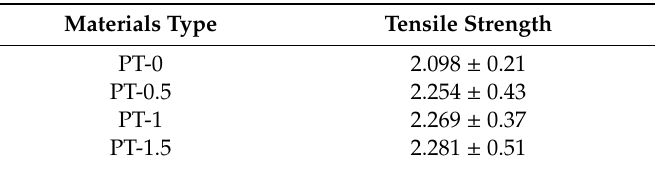
Table 5. Tensile strength of prepared membranes.